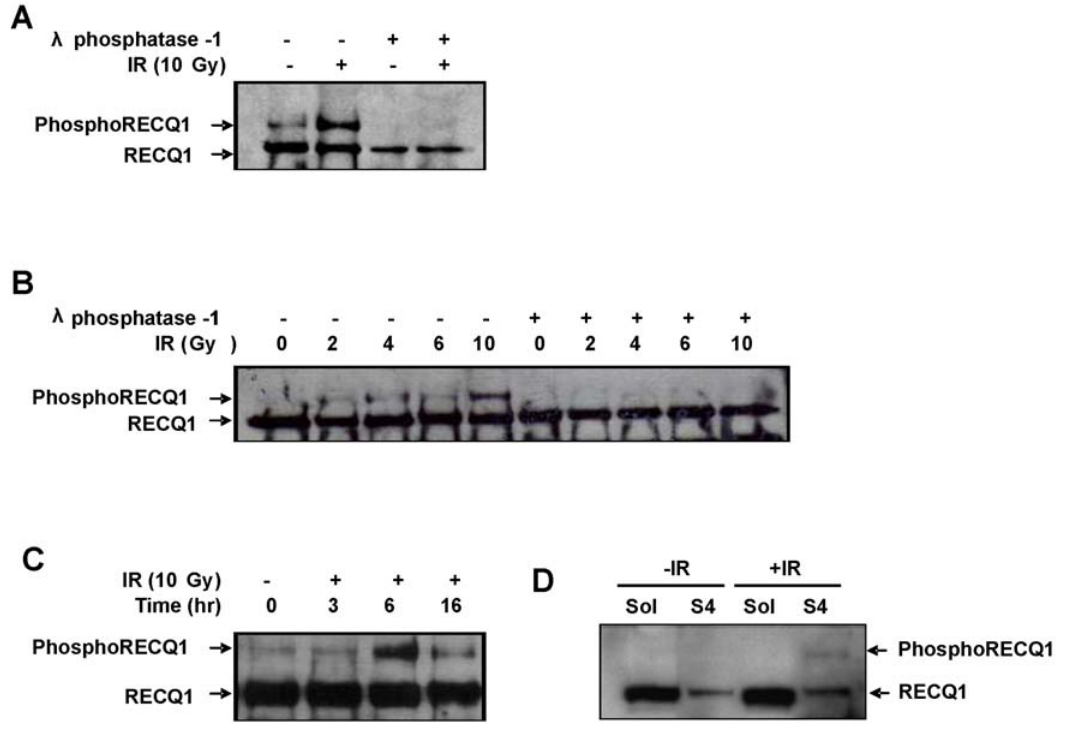
Figure 2. Phosphorylation of endogenous RECQ1 in response to IR. Panel A, RECQ1 was immunoprecipitated from whole cell extracts of U2OS cells that were either untreated or allowed to recover for 6 h from 10 Gy IR exposure. The RECQ1 immunoprecipitate from each cell extract was divided in half and was either incubated or not with l -phosphatase (500 U) for 1 h at 30 u C before elution with SDS sample buffer. The immunoprecipitated proteins were resolved on 12% SDS-PAGE, transferred to PVDF membranes, and probed for RECQ1. Panel B, IR-induced RECQ1 phosphorylation is dependent on radiation dose. RECQ1 was immunoprecipitated from either untreated cells or 6 h after treatment of cells with the indicated dose of c - radiation. Immunoprecipitated proteins were divided in two aliquots which were either treated with l -phosphatase or left untreated. RECQ1 was detected as described above. Panel C, Time course of RECQ1 phosphorylation in response to IR. U2OS cells were subjected to c -radiation (10 Gy), and RECQ1 was immunoprecipiated from whole cell extracts prepared at the indicated time points following IR exposure. Panel D, Phosphorylated RECQ1 is preferentially associated with chromatin in IR-treated cells. RECQ1 was immunoprecipitated from the detergent-soluble (S2) and insoluble (S4) fractions of untreated or IR treated cells, resolved on 12% SDS-PAGE, and detected by Western blot